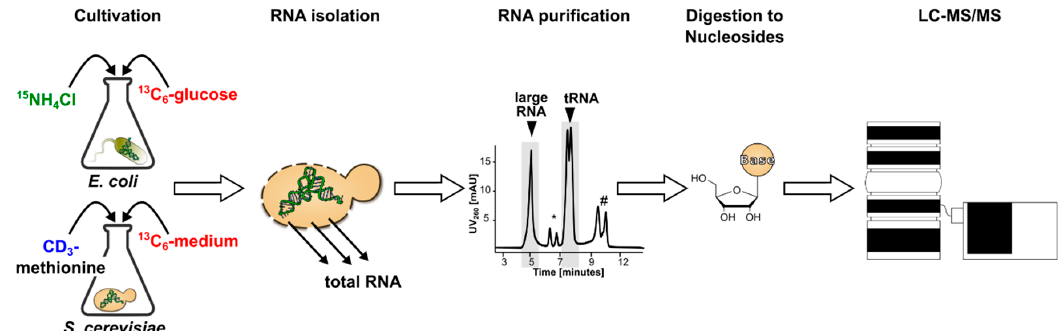
Figure 1. To produce stable isotope-labeled internal standards (SILIS), Escherichia coli ( E. coli ) or Saccharomyces cerevisiae ( S. cerevisiae ) were cultured in isotope labeled media using nutrients with the highest isotope-purity possible. The total RNA was isolated and then separated into transfer RNA (tRNA) or large/ribosomal RNA through size exclusion chromatography. (* indicates 5.8 and 5S rRNA and # phenol) The different RNAs were enzymatically digested into nucleosides and analyzed by liquid chromatography–mass spectrometry (LC–MS/MS).